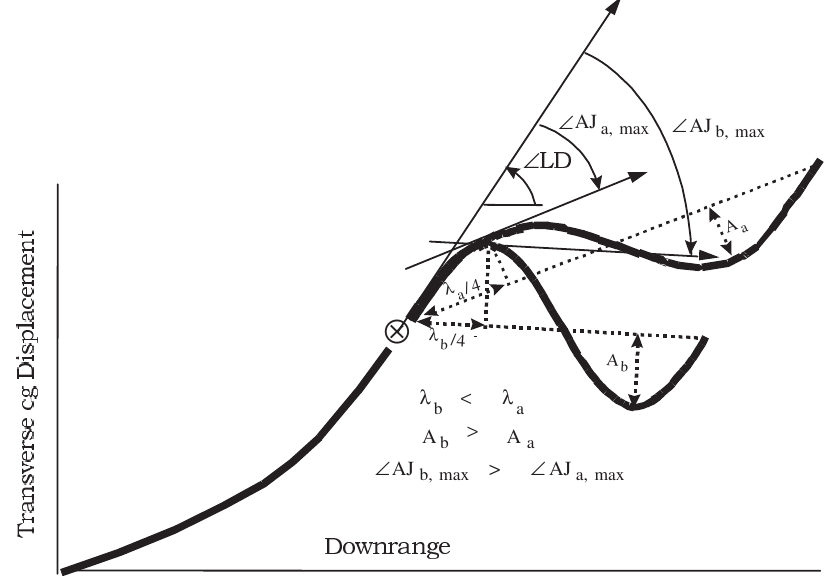
Fig. 8. Depiction of variation in (AJ max with amplitude and wavelength of the swerve curve.